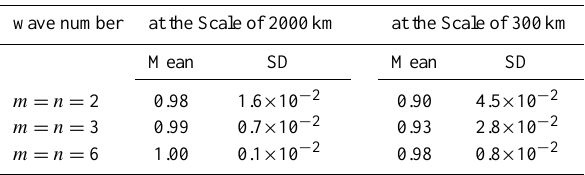
Table 3. Summary of the Temporal Mean and Standard Deviation (SD) of the Similarity of Horizontal Kinetic Energy at 850hpa of January 2010 at Different